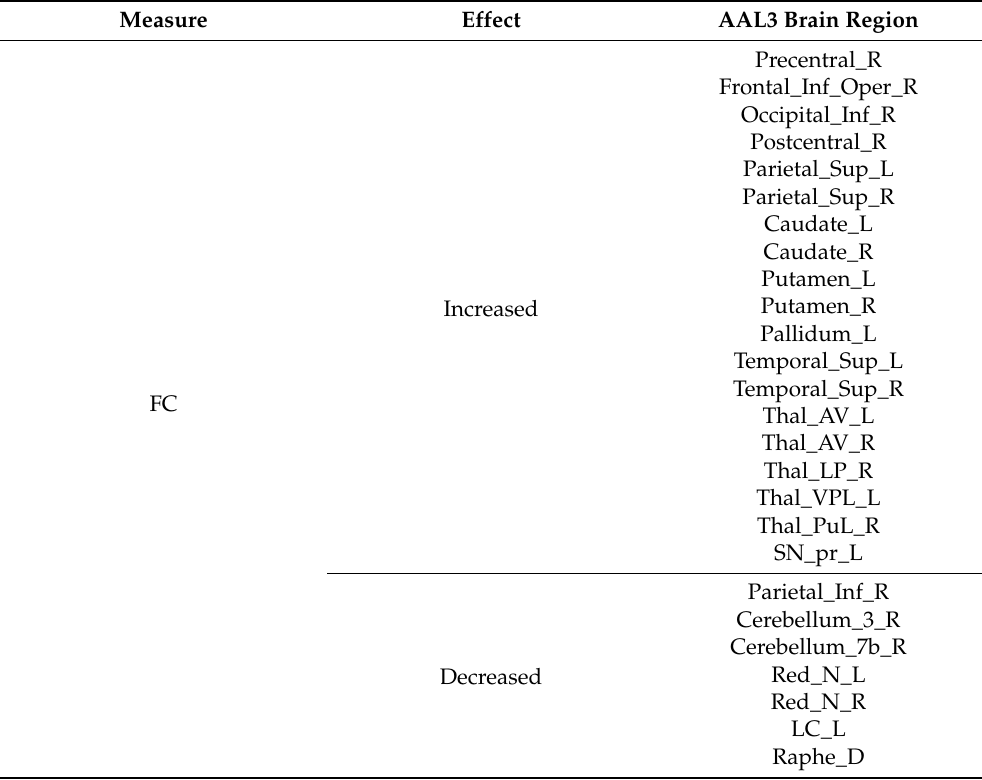
Table 1. ROIs of increased and decreased ICCs for each metric when the difference value between before and after the correction was >0.1. Measure Effect AAL3 Brain